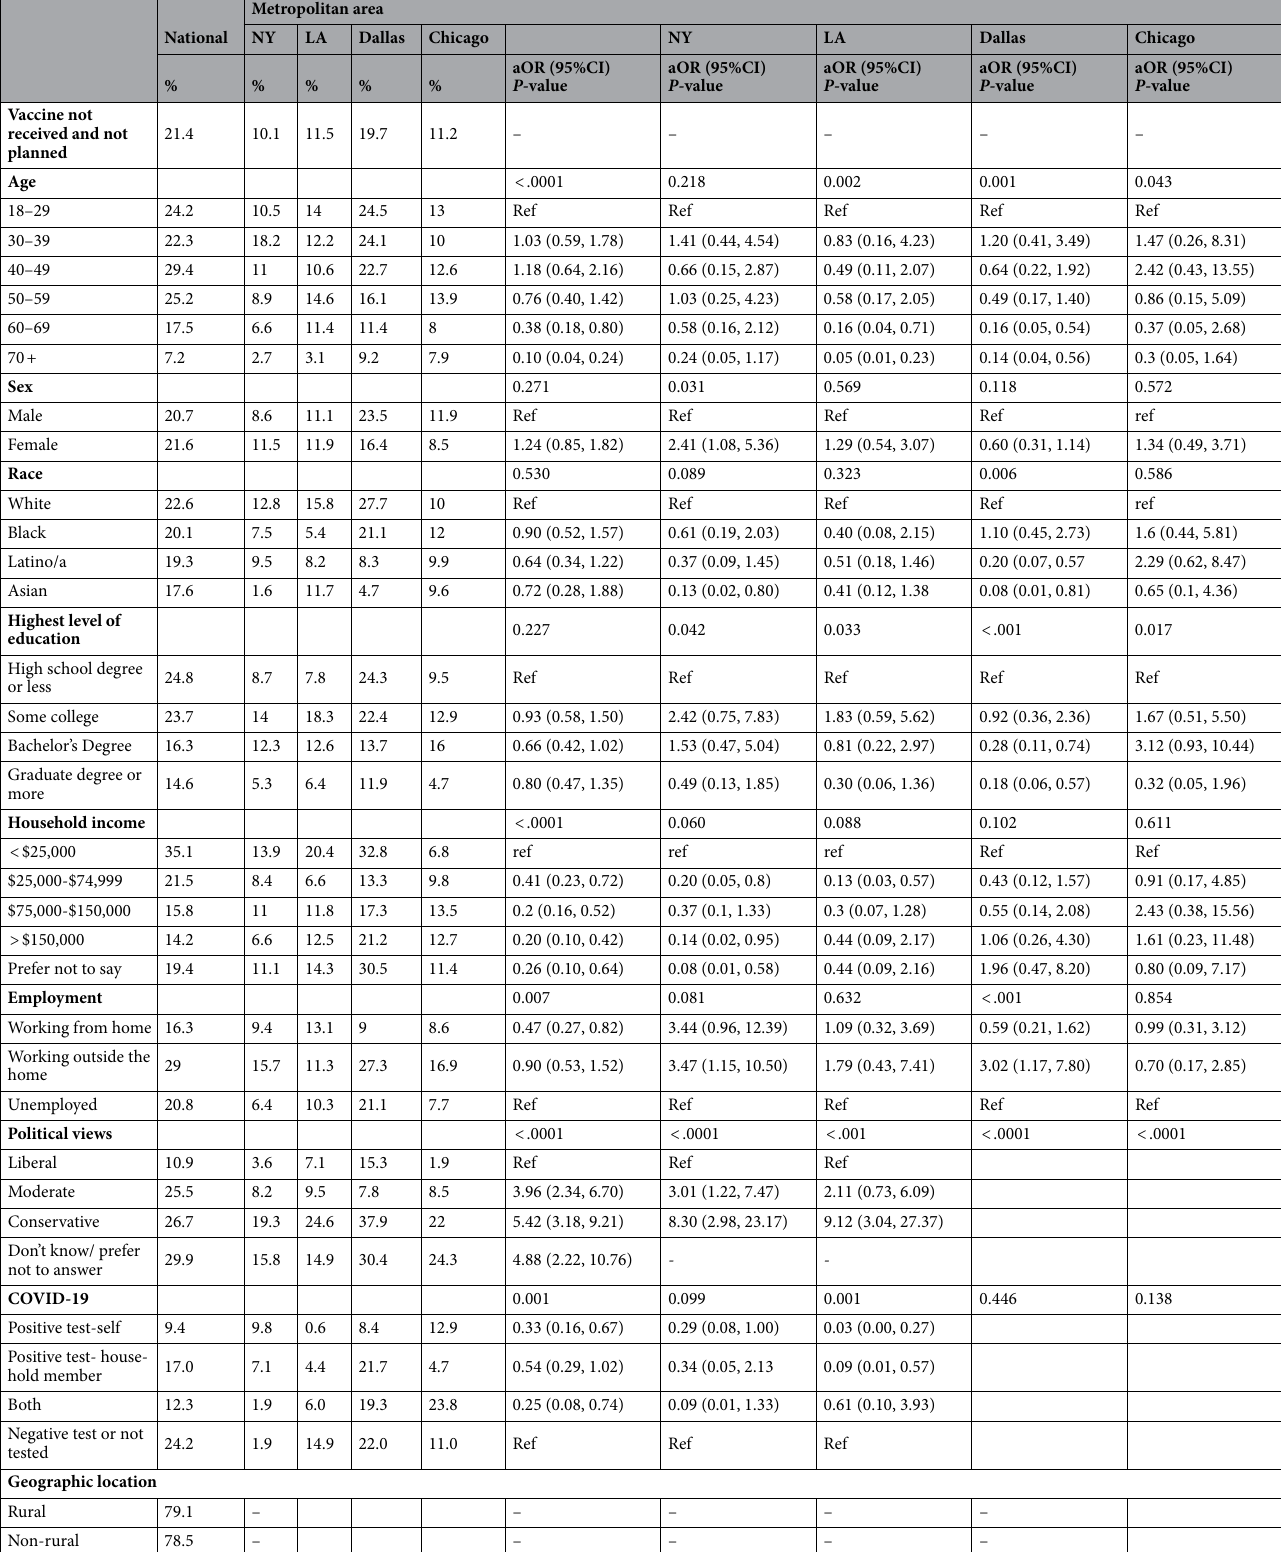
Table 3. Unwillingness to vaccinate by sociodemographic factors. % are weighted to the geographic population; P -value is for Type 3 test of overall effects based on weighted logistic regression (outcome = unwillingness to vaccinate). In the Chicago metropolitan area model reference category for political view was changed to moderate due to small sample size in the liberal category. aOR adjusted odds ratios, CI confidence